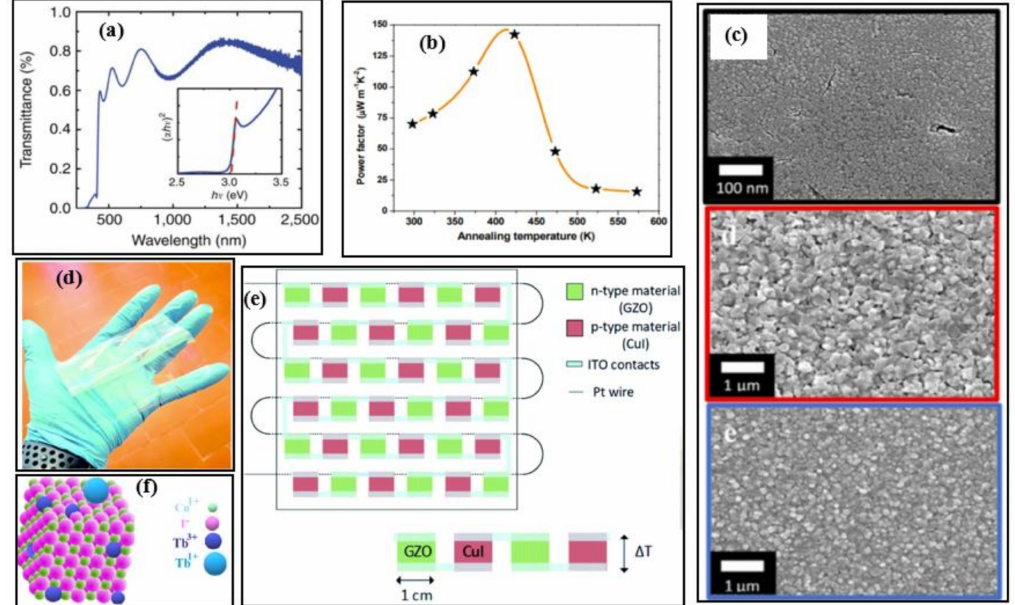
Figure 2. ( a ) Transmittance spectra of copper iodide thin film deposited of glass (thickness of 300 nm), Reproduced with permission from [9]. Copyright © 2017, Nature Communications, ( b ) Room temperature power factors of copper iodide at different annealing temperatures, Reproduced with permission from [10]. Copyright © 2018, Wiley Online Library, ( c ) SEM image of nanostructured CuI synthesized using vapour iodination and thermal evaporation, Reproduced with permission from [11]. Copyright © 2018, Scientific Reports Nature. ( d ) A 10 × 10 cm 2 Kapton-based copper iodide (CuI) and gallium-doped zinc oxide (GZO) based thermoelectric generator prototype, Reproduced with permission from